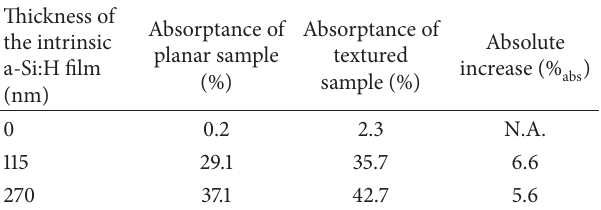
Table 1: AM1.5G weighted average absorptance 𝐴 𝑤 of the four sam- ples of Figure 3, integrated over the wavelength range 400–800 nm. Also shown are the absorptances of the bare (i.e., noncoated) glass sheets.